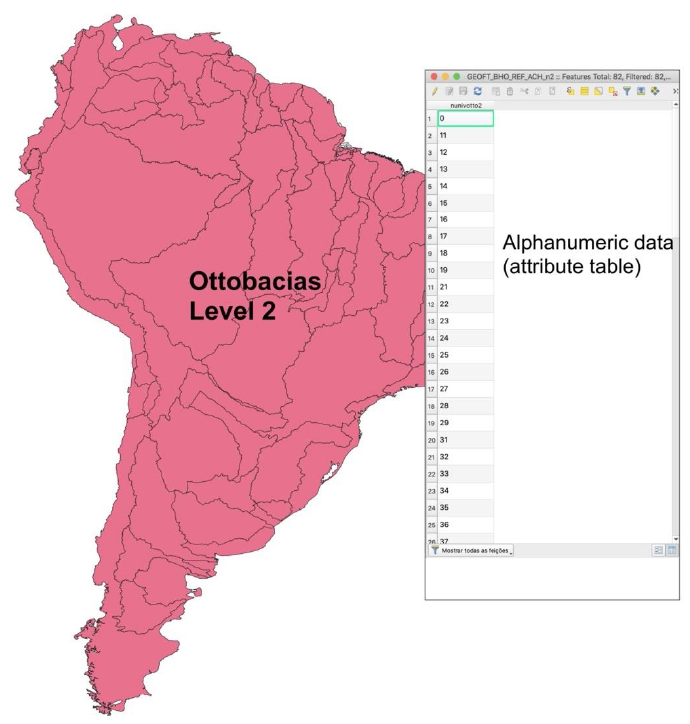
Figure 11 . Alphanumeric data referring to Ottobacias (Brazil — level 2). Figure 11. Alphanumeric data referring to Ottobacias (Brazil—level 2).